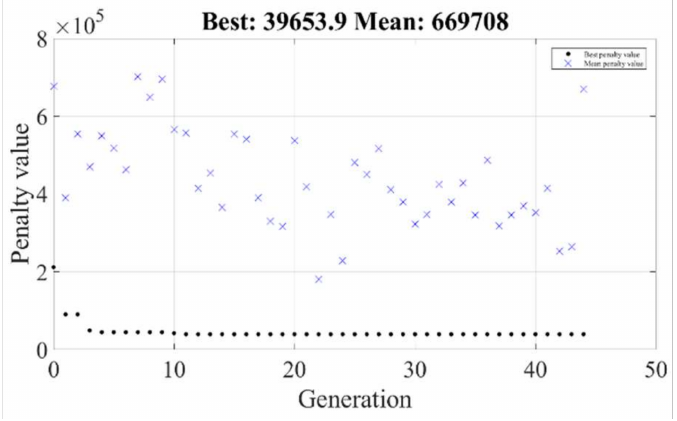
Figure 3. The convergence of single GA optimization method for ANFIS-SR.